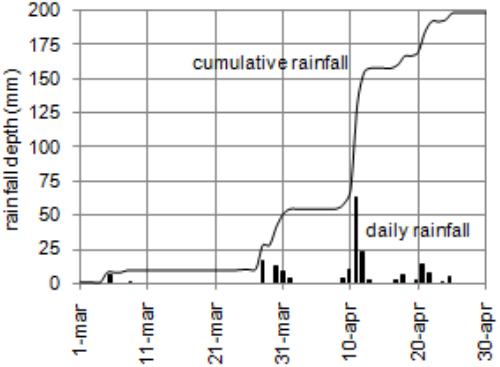
Fig. 3. Daily and cumulative rainfalls measured from 1 March to 30 April 2005 at Baiso rain